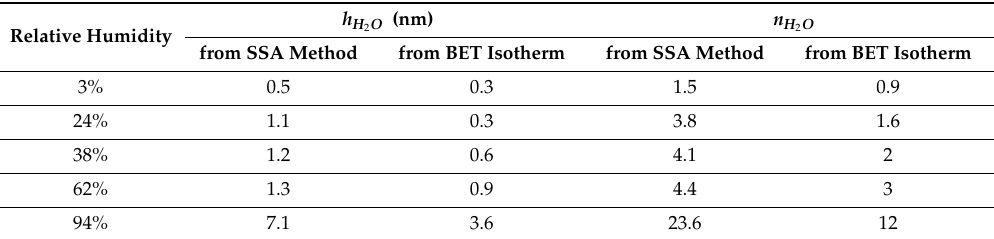
Table 4. Estimated water layer thickness and number of monolayers of H 2 O molecules (n H2O ) and mean water layer thickness (h H2O) adsorbed on the surface of GoHAP-1 (10 nm), depending on experimental conditions and an exposure time of 20 h.